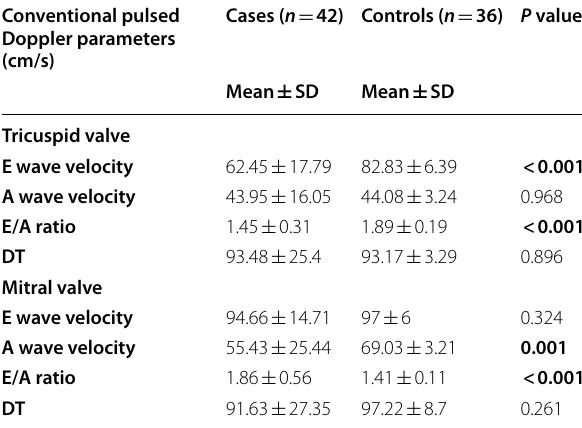
Table 3 Pulsed wave Doppler imaging measurements in celiac disease patients and healthy